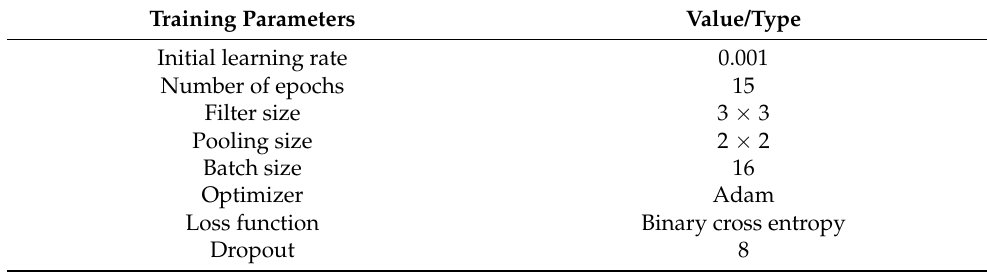
Table 2. Summary of training parameter for U-Net